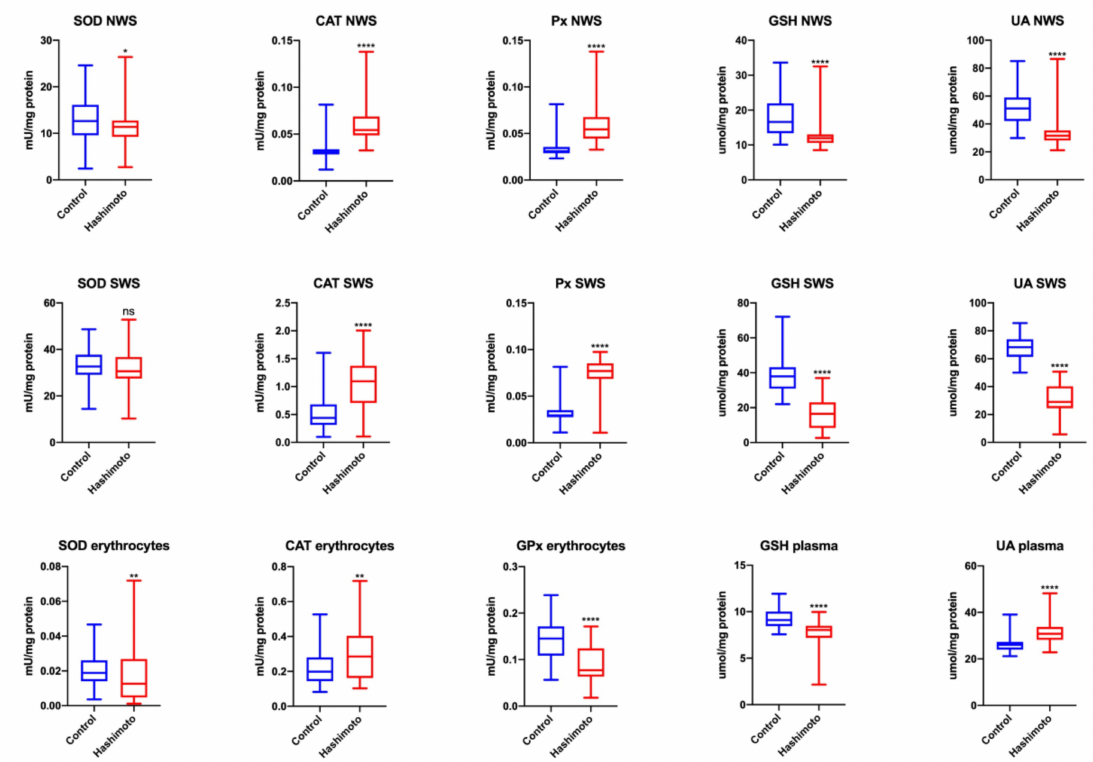
Figure 1. Enzymatic and nonenzymatic antioxidants in NWS, SWS and blood plasma / erythrocytes of the patients and control group. Data are shown as median (minimum–maximum).